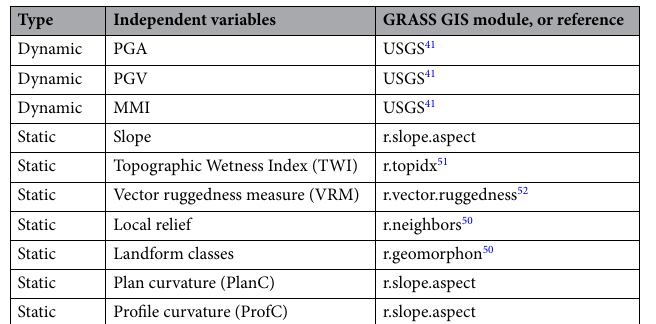
Table 2. List of independent variables as studied in Tanyas et al. 7 and adopted here. We mentioned the GRASS GIS modules used to calculate each variable at grid cell level, from which mean and S.D were subsequently obtained at SU